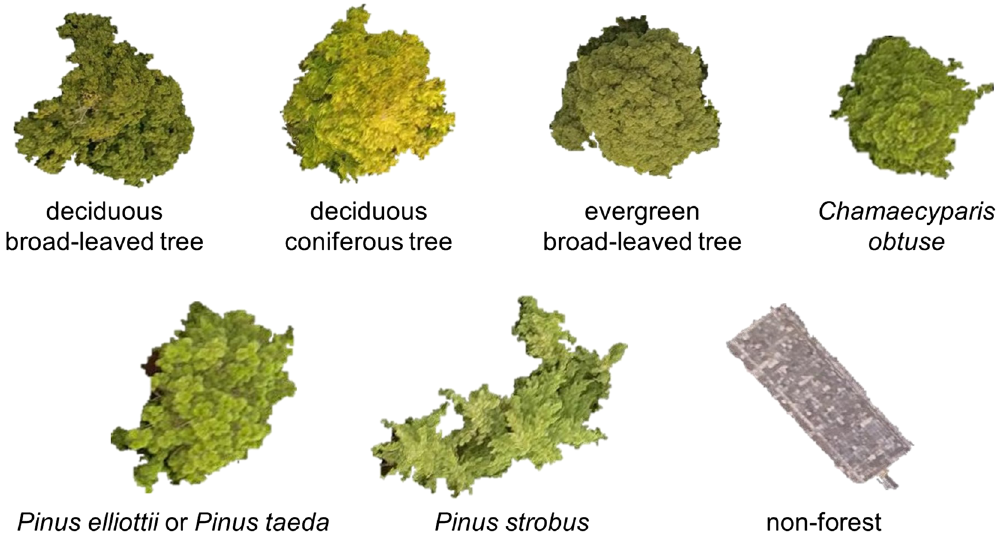
Figure 5. Representative extracted images from each class in the October 2 images. These images were extracted from the same tree crown map polygon as the November 20